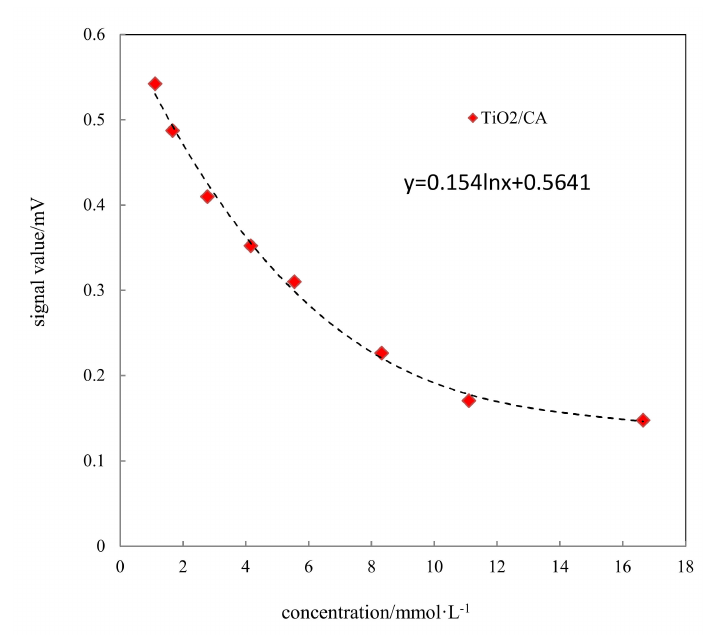
Figure 9. Standard curves of glucose detection